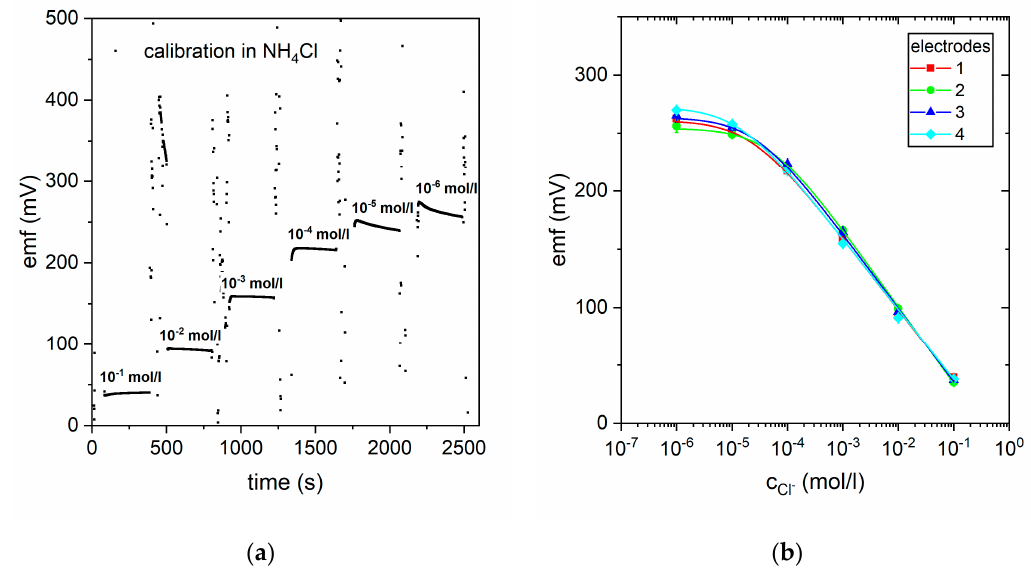
Figure 3. ( a ) Potentiometric response curve of the screen-printed chloride sensor measured in NH 4 Cl solutions with different concentrations. ( b ) Resulting calibration plot measured in NH 4 Cl solutions of four different chloride-selective electrodes sharing one reference electrode. Table 2. Comparison of screen-printed chloride sensor to the standard sensor system.